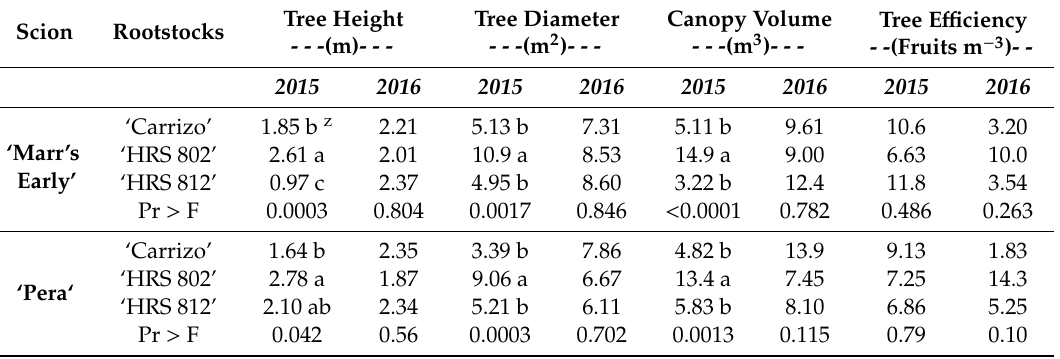
Table 4. Tree height, area, canopy, and e ffi ciency of two sweet orange cultivars grafted on three di ff erent rootstocks growing on Alonso clay series soil at the Agricultural Experiment Substation of Adjuntas, Puerto Rico in